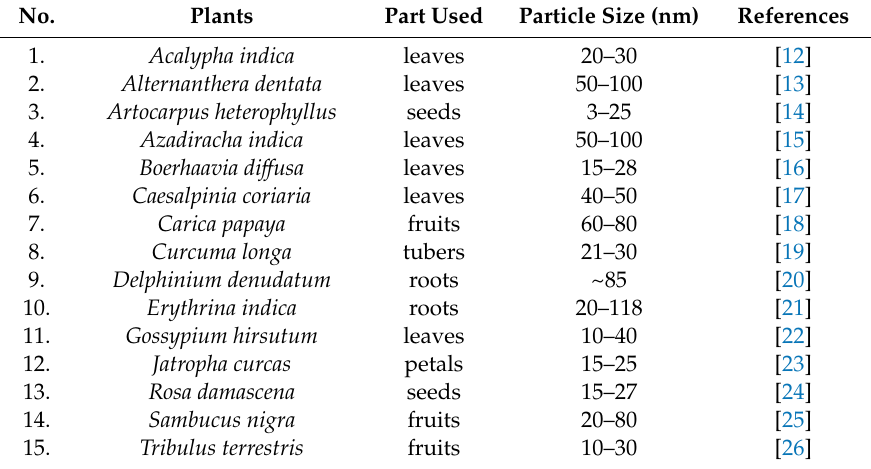
Table 1. Various plant extracts used for the green synthesis of silver nanoparticles. No. Plants Part Used Particle Size